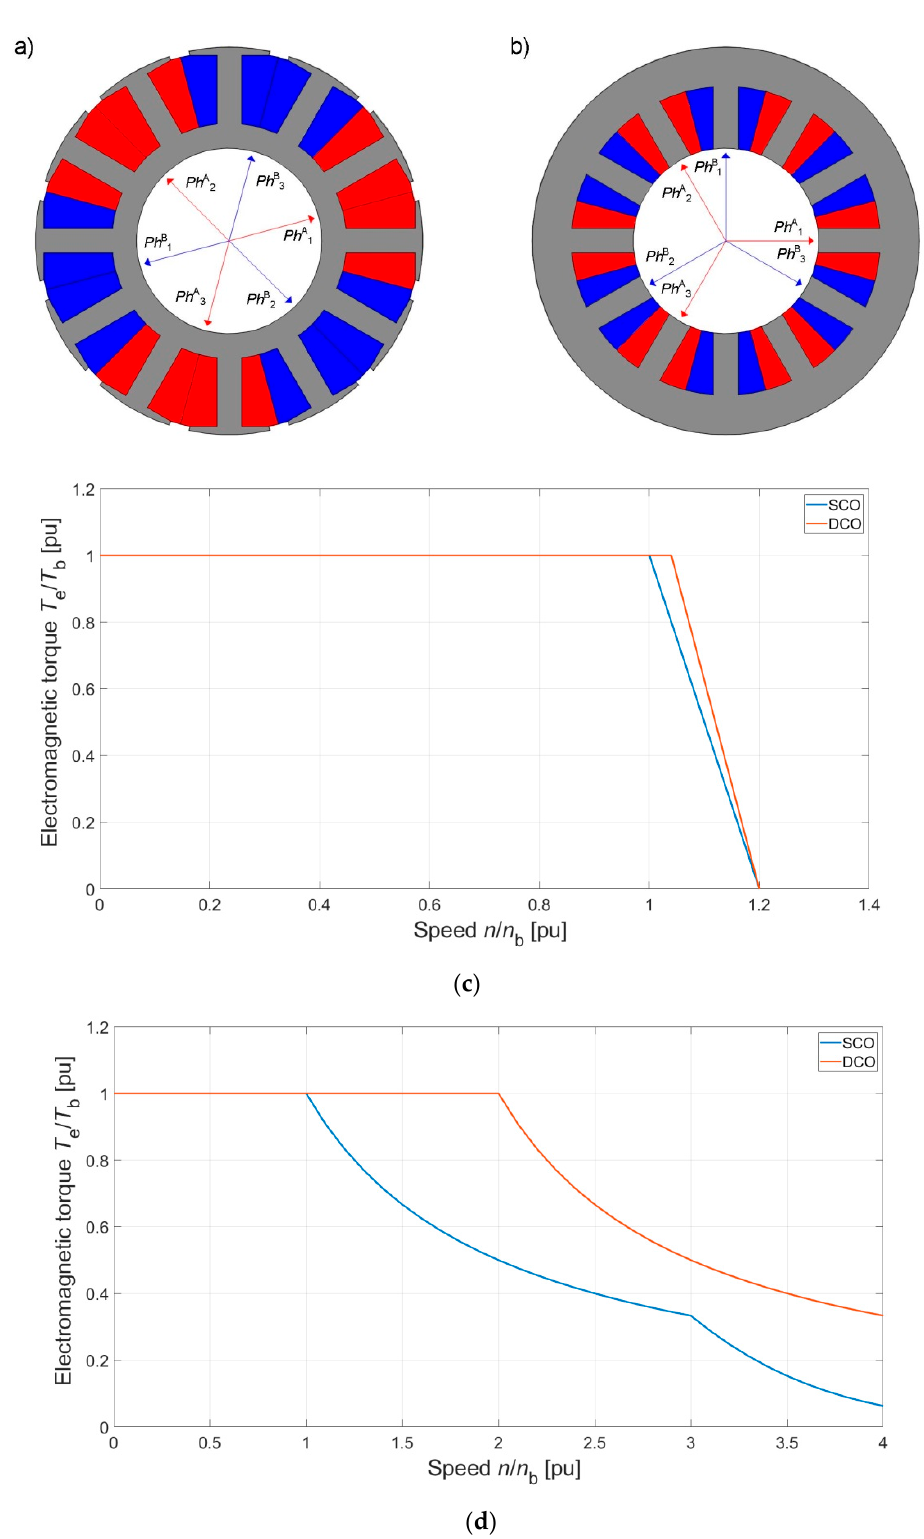
Figure 2. A scheme of winding distributions of channels A and B on a stator of the three-phase DCBLDCM and DCSRM and theoretical torque vs. speed characteristics: (a) DCBLDCM, (b) DCSRM, (c) torque vs. speed for DCBLDCM, and (d) torque vs. speed for DCSRM.